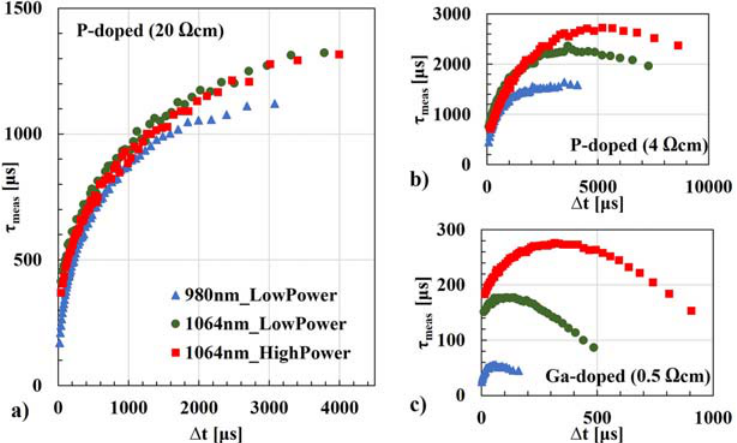
Fig. 6. Measured t meas curves during the PCD decay. (a) The high quality n-type slab featuring negligible injection level dependence (ILD) shows a similarly increasing t eff ( t ) regardless of laser wavelength and power. In the case of stronger ILD (b and c) longer wavelength and elevated laser power makes possible to determine the lifetime closer to the saturation value of t b . (Low power: 3 (cid:3) 10 18 cm (cid:1) 2 s (cid:1) 1 used in WT-1200I, High power: 2 (cid:3) 10 19 cm (cid:1) 2 s (cid:1) 1 is used in WT-1200. IL).